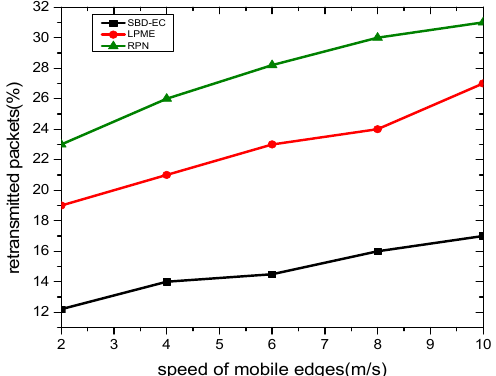
Figure 9. Retransmitted packets and mobility.